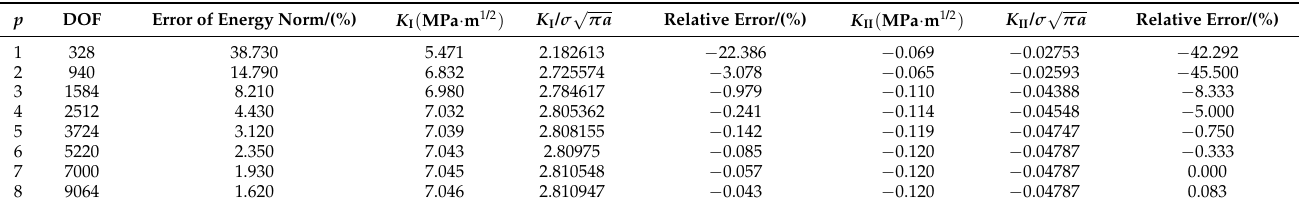
Table 8. Errors of energy norm of the P-FEM solutions and relative errors of SIFs ( L/W = 3, c/L = 0.3) comparison with Chen et al. [8].